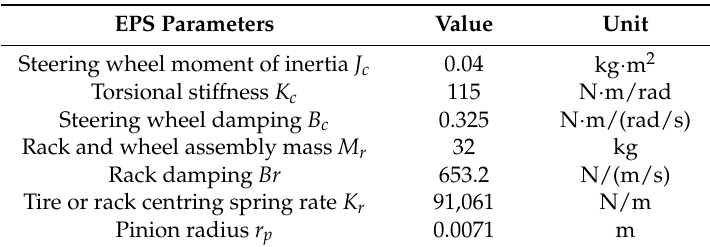
Table 7. EPS parameters.